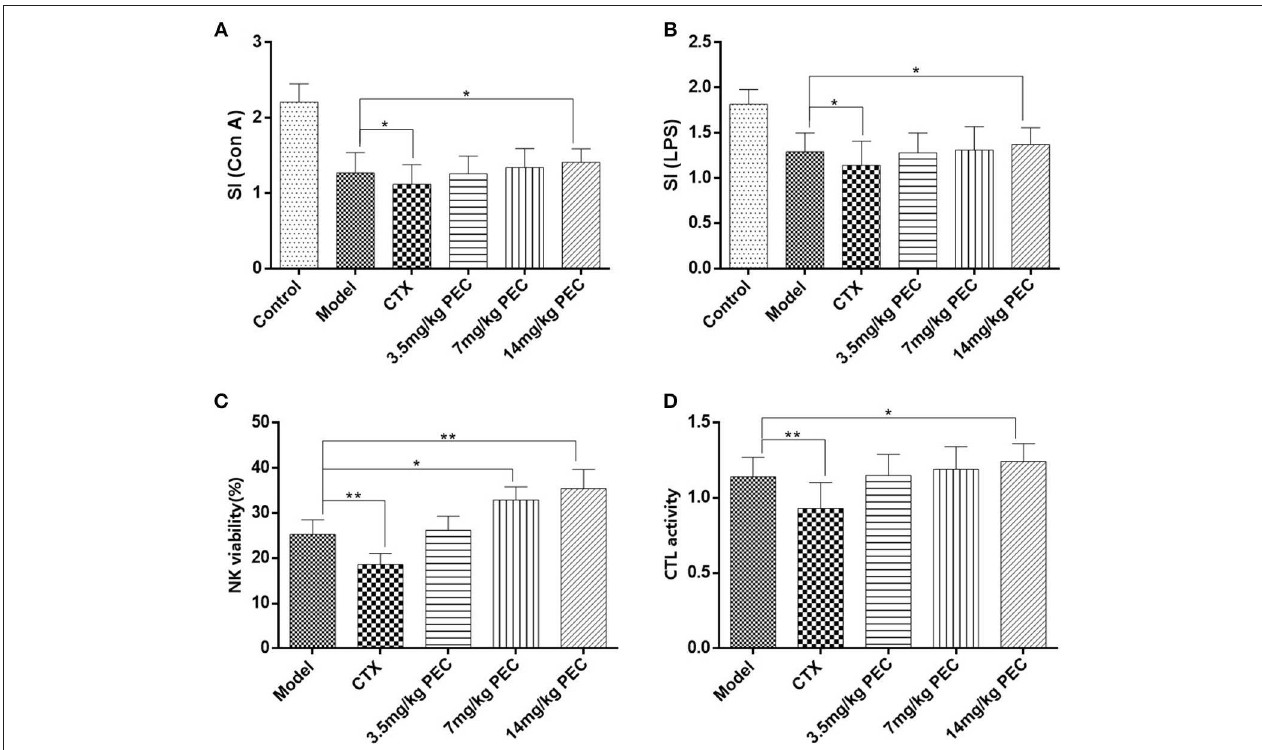
FIGURE 5 | Effects of PEC on splenic lymphocyte proliferation induced by (A) ConA and (B) LPS in S-180 tumor-bearing mice. (C) Effects of PEC on NK in S-180 tumor-bearing mice ( ¯ x ± s, n = 10). (D) Effects of PEC on CTL in S-180 tumor-bearing mice ( ¯ x ± s, n = 10). Compared with model group: * P < 0.05, ** P <